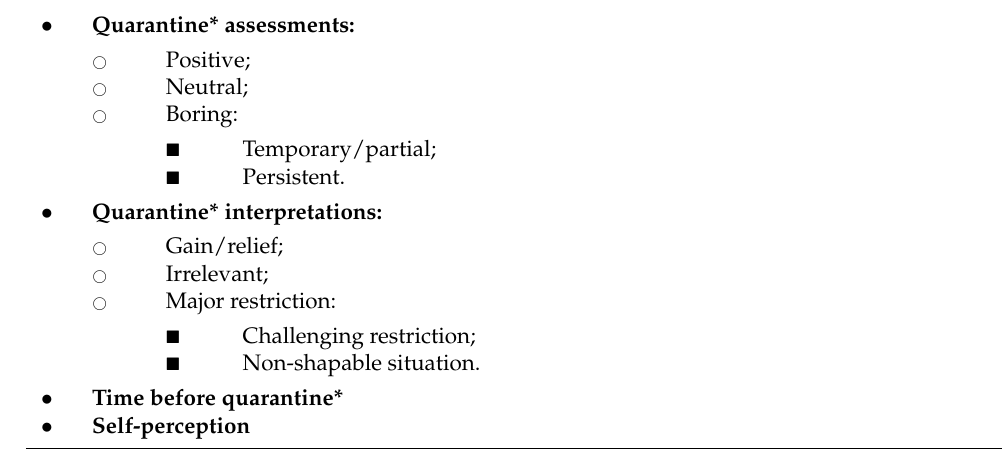
Table 2. Overview of the Code